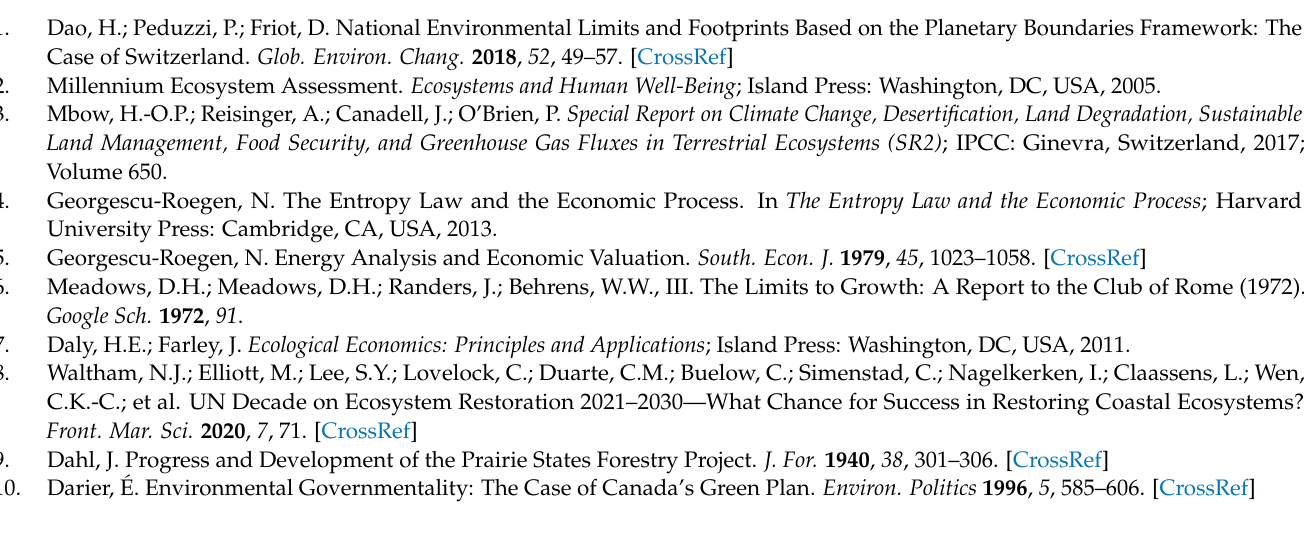
on the Loess Plateau; (c) Average Vegetation carbon sequestration of Loess Plateau, 2002–2018; Figure S4: Soil retention of Loess Plateau, 2002–2018; Figure S5: (a) Distribution of hydrological stations on the Loess Plateau; (b) Average sand transport modulus of Loess Plateau, 1987–2015; (c) Average soil erosion modulus of Loess Plateau, 2002–2018; Figure S6: Biodiversity service of Loess Plateau, 2002–2018; Figure S7: Water conservation service of Loess Plateau,